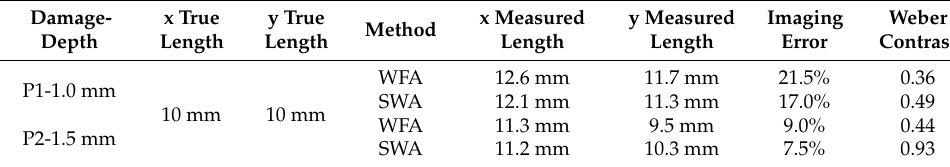
Table 2. Evaluation of damage imaging results of aluminum plates.